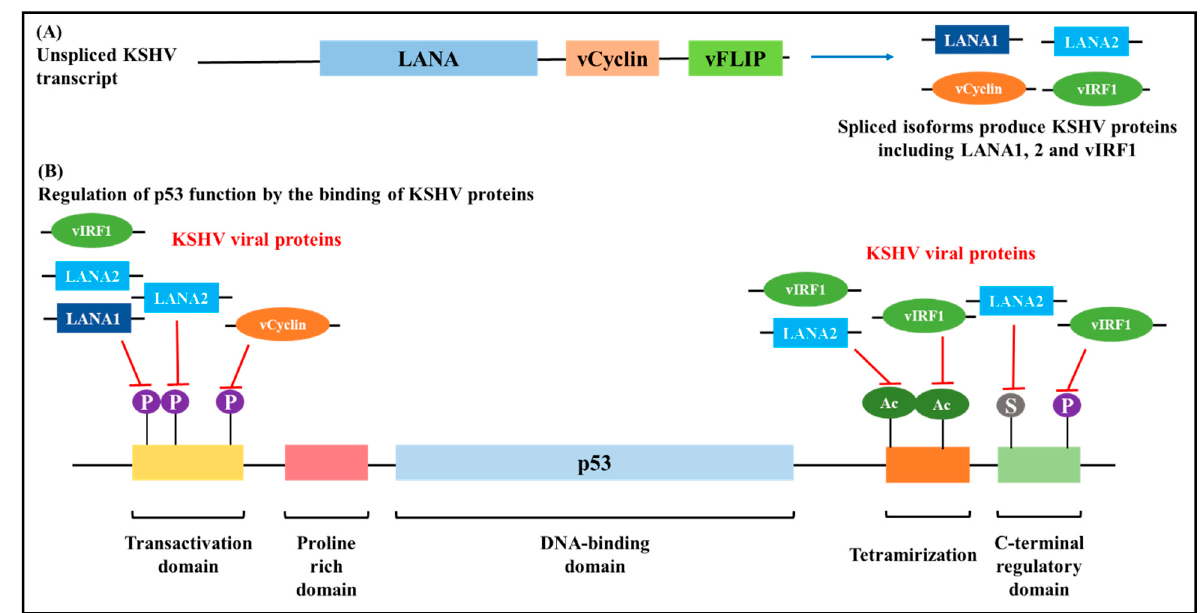
Figure 7. Post-transcriptional regulation of p53 by Kaposi’s Sarcoma Herpesvirus (KSHV) viral proteins. ( A ): Viral RNA isoforms produce several proteins that bind to p53 in different regions and suppress its activity. ( B ): p53 phosphorylation is regulated by the binding of vCyclin, LANA1, LANA2 and vIRF1 at different regions. LANA1, LANA2 and vIRF1 inhibit the phosphorylation whereas vCyclin induces it. p53 protein plays vital roles in cell cycle regulation, and with loss of function of p53, KSHV induces carcinogenesis [36,82,83].